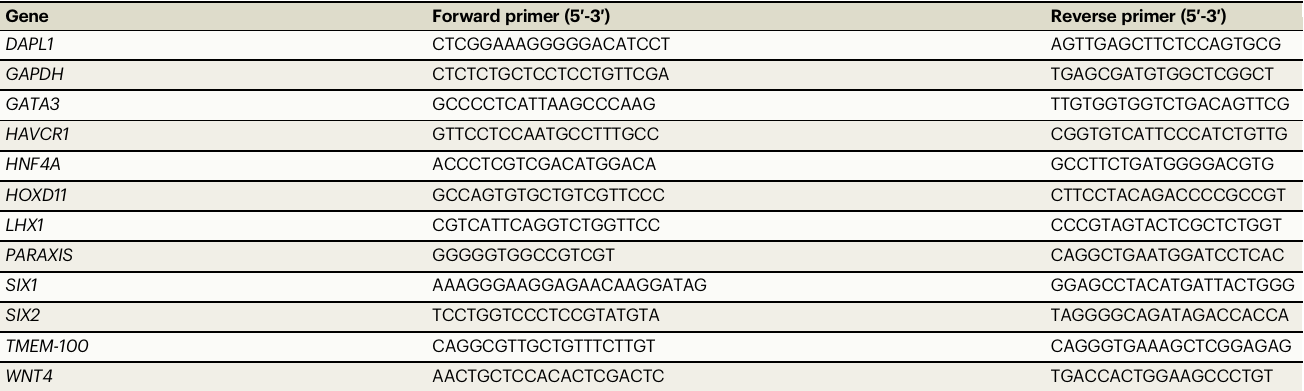
Table 2 | Forward and reverse primers used for